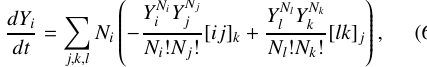
BBN predicts a 7 Li / H of abundance of ∼ 10 − 10 and a 6 Li / H abundance of ∼ 10 − 14 . After the BBN era ( (cid:38) 20 min), the universe cooled down and no more elements